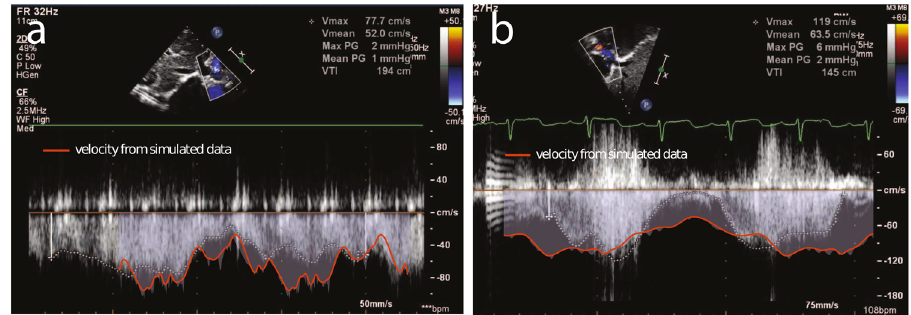
Fig. 5 Validation of simulated stenosis against echocardiograph data of in vivo stenosed grafts. a Patient 2 at 6 months post-implantation (graft diameter of 5.6 mm by echocardiogram) measured echo velocity compared to Patient 2 at 6 months (simulated stenosis of 6.0 mm graft